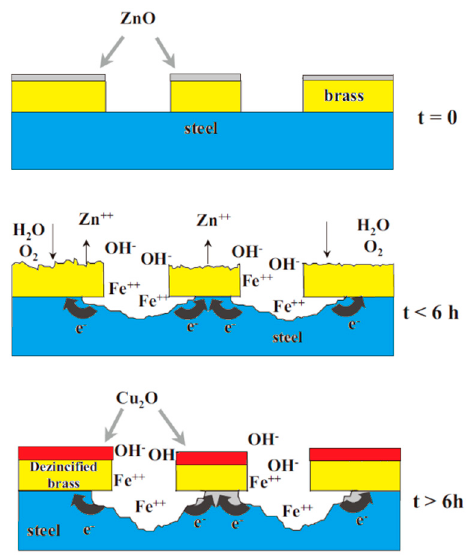
Figure 22. Schematic representation of the corrosion mechanism of brass-coated steel wire (corro- sive medium: 0.25-M Na 2 SO 4 solution). Reprinted with permission from ref. [38]. medium: 0.25-M Na 2 SO 4 solution). Reprinted with permission from ref.